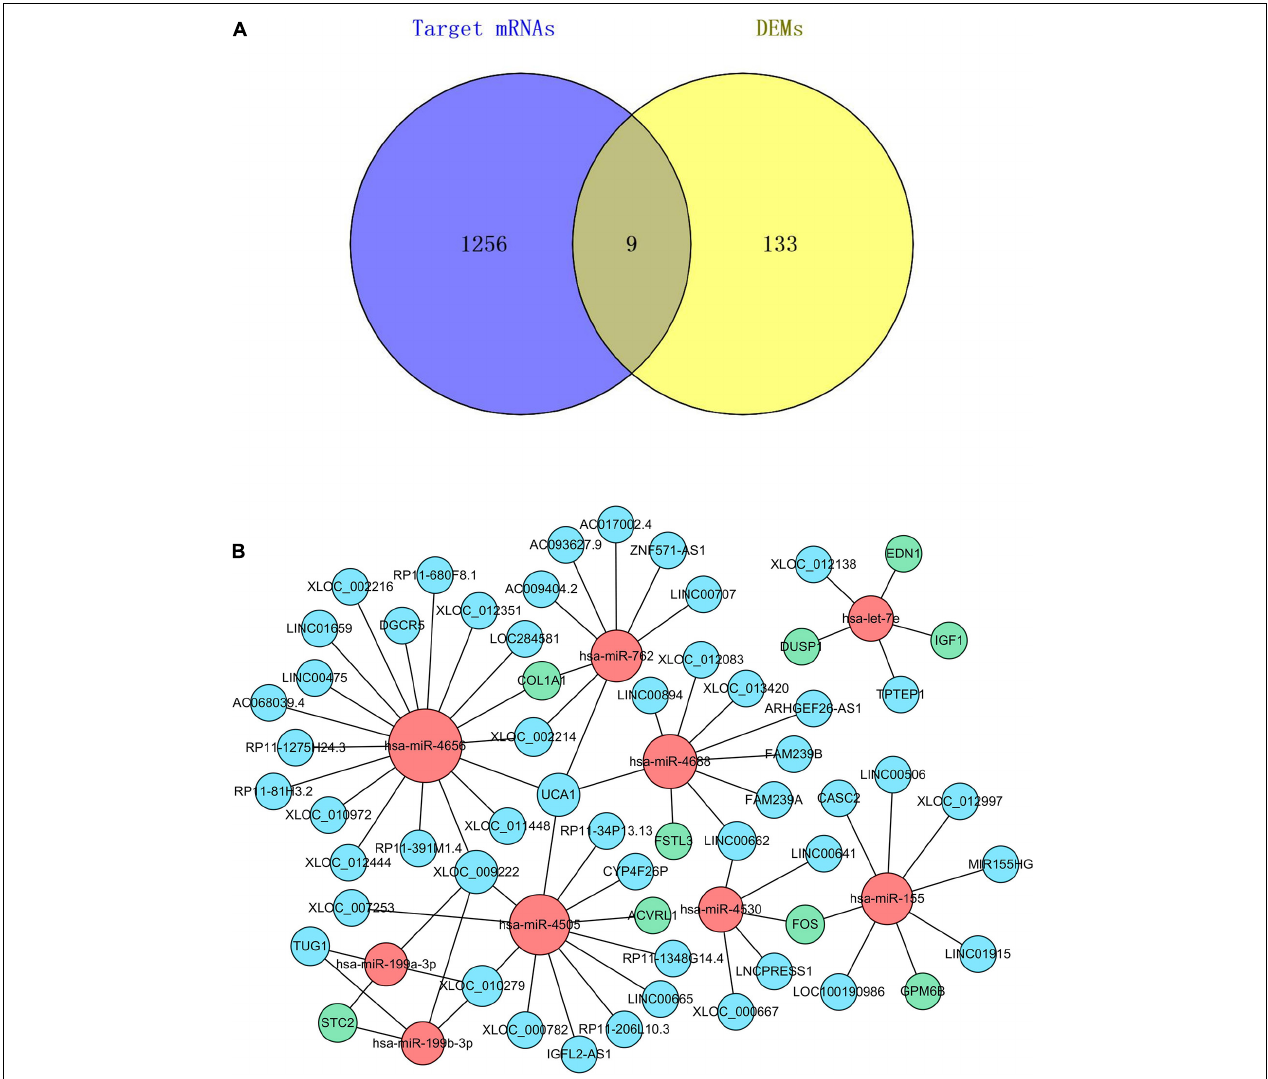
FIGURE 5 | The core mRNAs identification and ceRNA regulatory network in SSc-ILD. (A) The intersection between DEMs and the target genes of DEmiRs. (B) The ceRNA regulatory network. The red dots represent DEmiRs, the green dots represent core mRNAs, and the blue dots represent predicted lncRNAs. mRNAs, messenger RNAs; ceRNA, competing endogenous RNA; SSc-ILD, systemic sclerosis-associated interstitial lung disease; DEMs, differentially expressed mRNAs; DEmiRs, differentially expressed microRNAs; lncRNAs, long non-coding